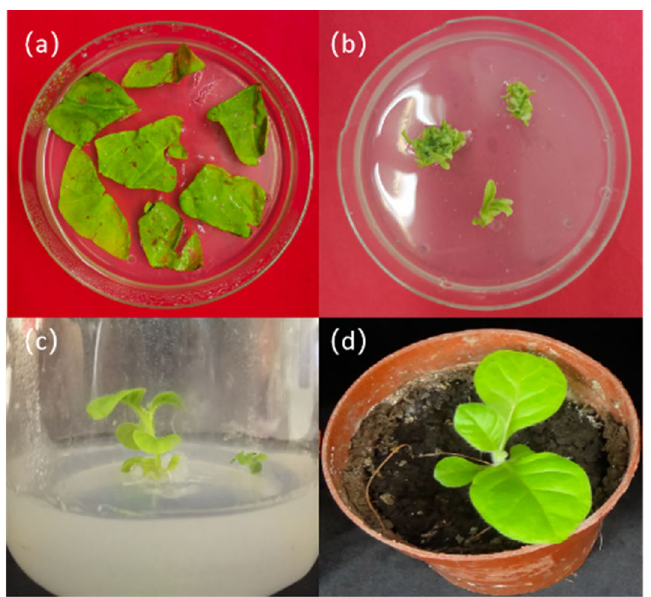
Figure 7. Resistance screening of genetically modified tobacco. ( a ) Cocultivation; ( b ) Induced resistance of differentiated buds; ( c ) Rooted tissue culture seedlings; ( d ) Transplantation into